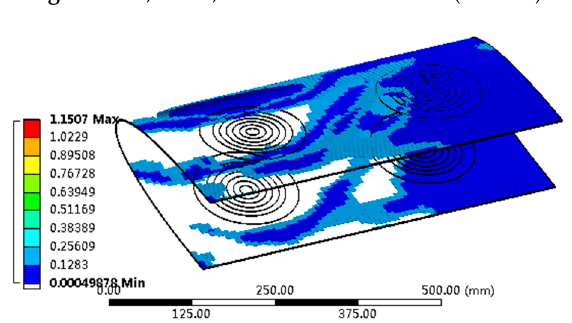
Figure 15. 1, 2 or 3, 4 of four coils are used (Mode 1).